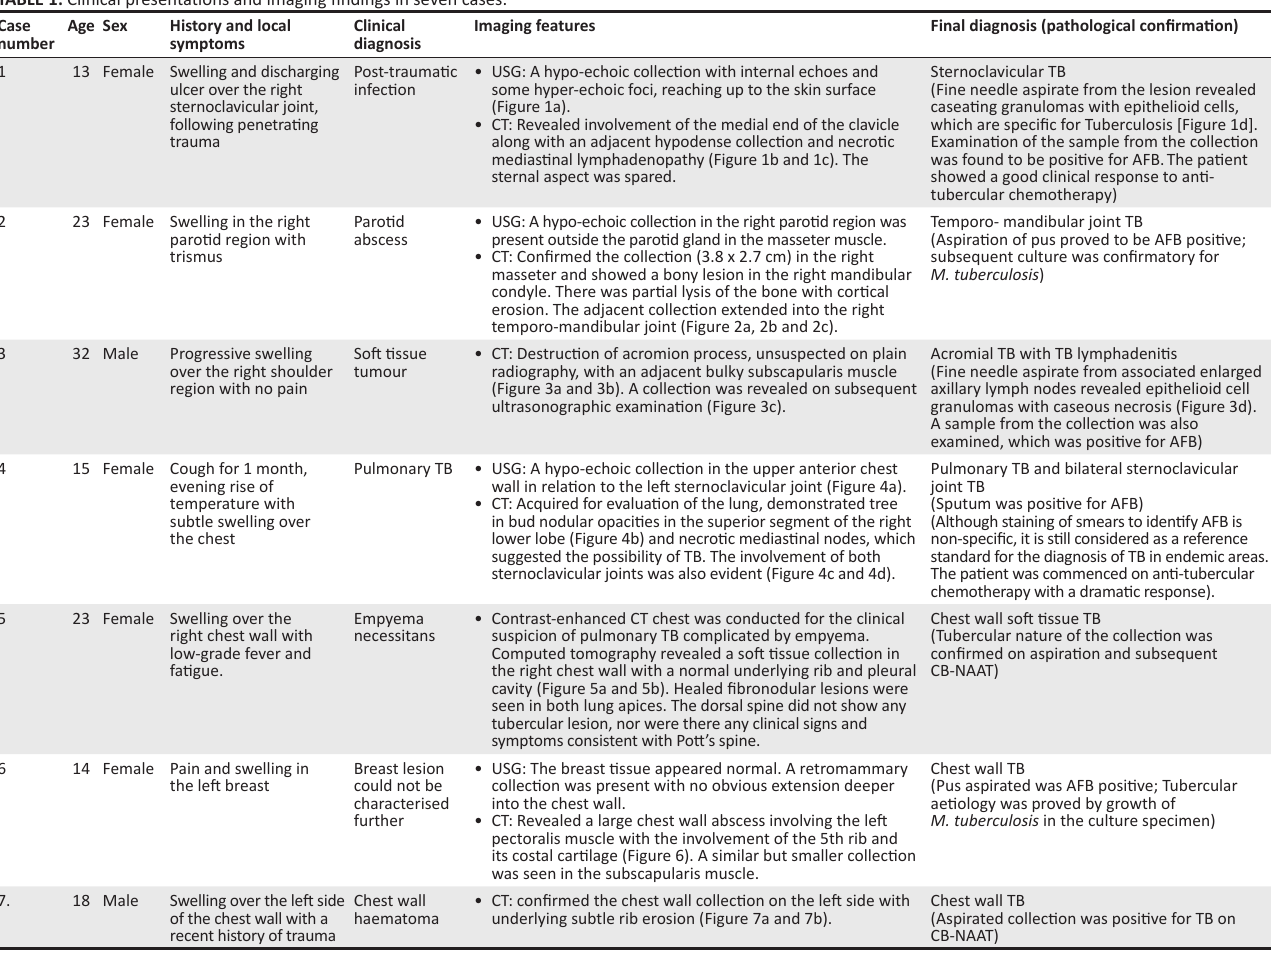
TABLE 1: Clinical presentations and imaging findings in seven cases.